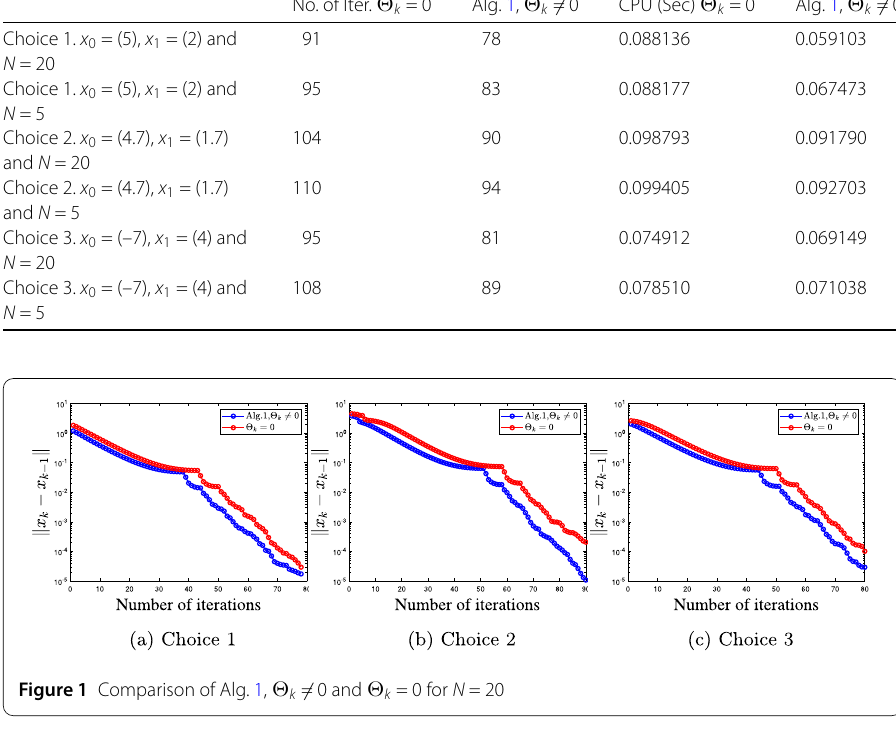
L = 3, and m = 0.01. Since